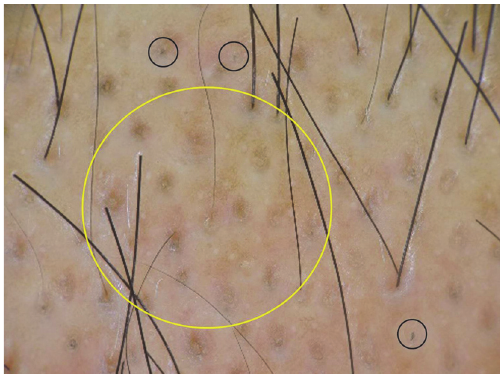
Figure 3: Dermoscopic examination showed mostly yellow dots (yellow circle), black dots (black circles), short vellus hairs, and blue-grey dots in a target pattern around yellow dots and follicles (polarized mode; 60x). 2935 mGy